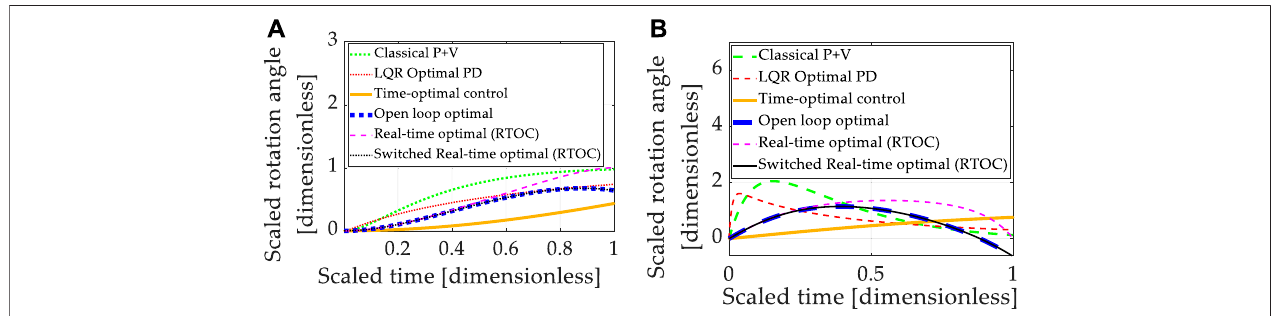
FIGURE 4 | Double-integrator plant (no transport theorem) with control design based on double-integrator. (A) Motion states (translation or rotational) normalized topropagatefromzeroandunityinonenormalizedsecond. (B) Motion rates (translationorrotational)intendedtopropagatefromzeroinitialvelocitytozerovelocityatthe endpoint in one normalized